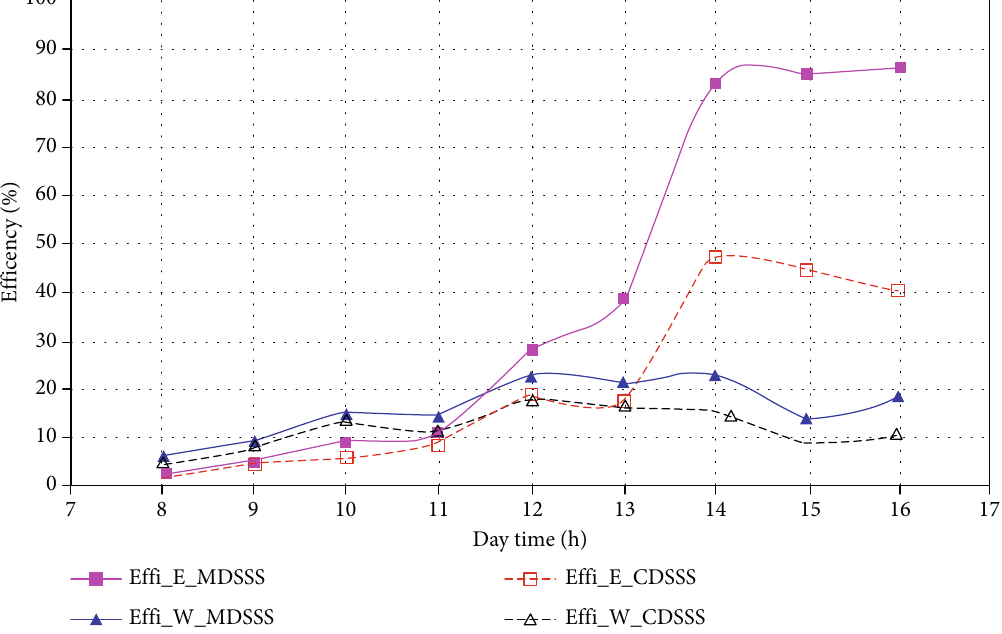
Figure 14: E ff ect of orientation and preheating on hourly e ffi ciency